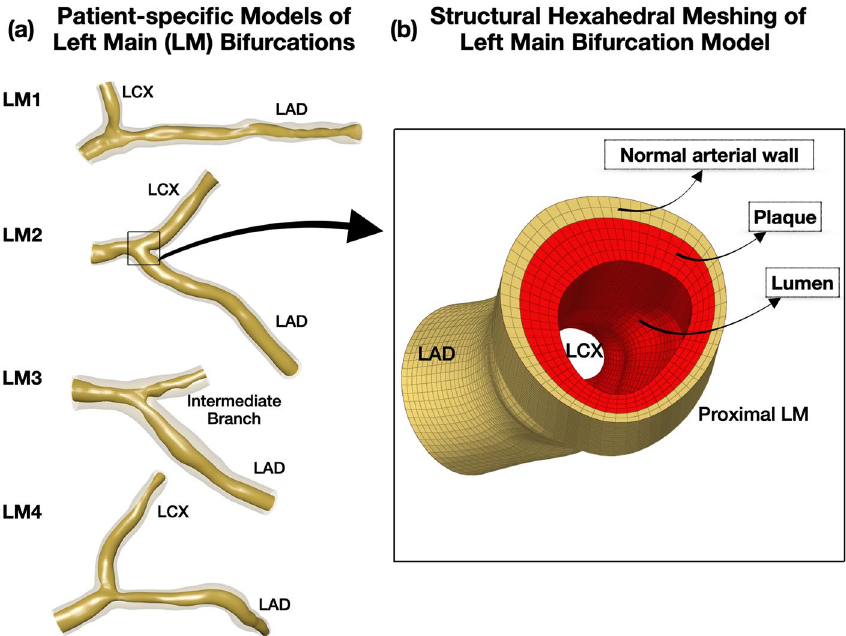
Figure 1. 3D reconstructed patient-specific left main (LM) bifurcation geometries. ( a ) 3D reconstructed lumen and wall of n = 4 patient-specific LM geometries using angiography and OCT imaging, ( b ) Magnification of the structured hexahedral mesh of a 3D reconstructed bifurcation. Note the normal wall (yellow) and plaque (red); LAD: Left anterior descending, LCX: Left circumflex